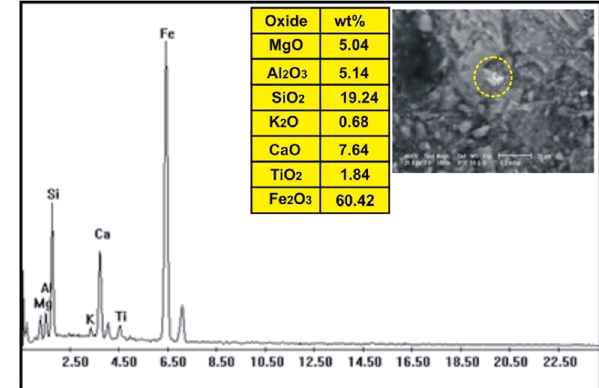
Figure 12: ESEM - EDX analysis of magnetite in basalt dike at Wadi Geba.